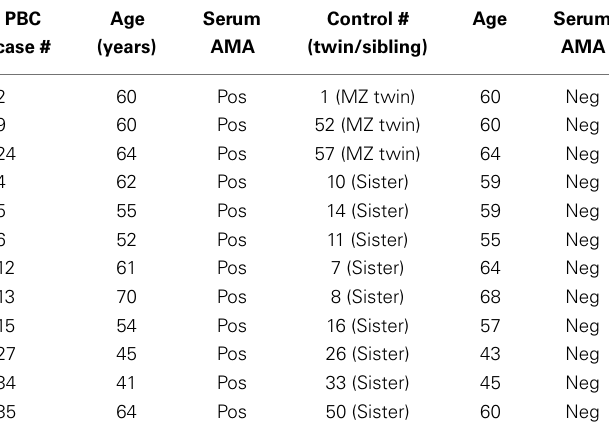
Table 1 | Summary of the patients with PBC and the corresponding healthy sibling and twin sisters utilized in the